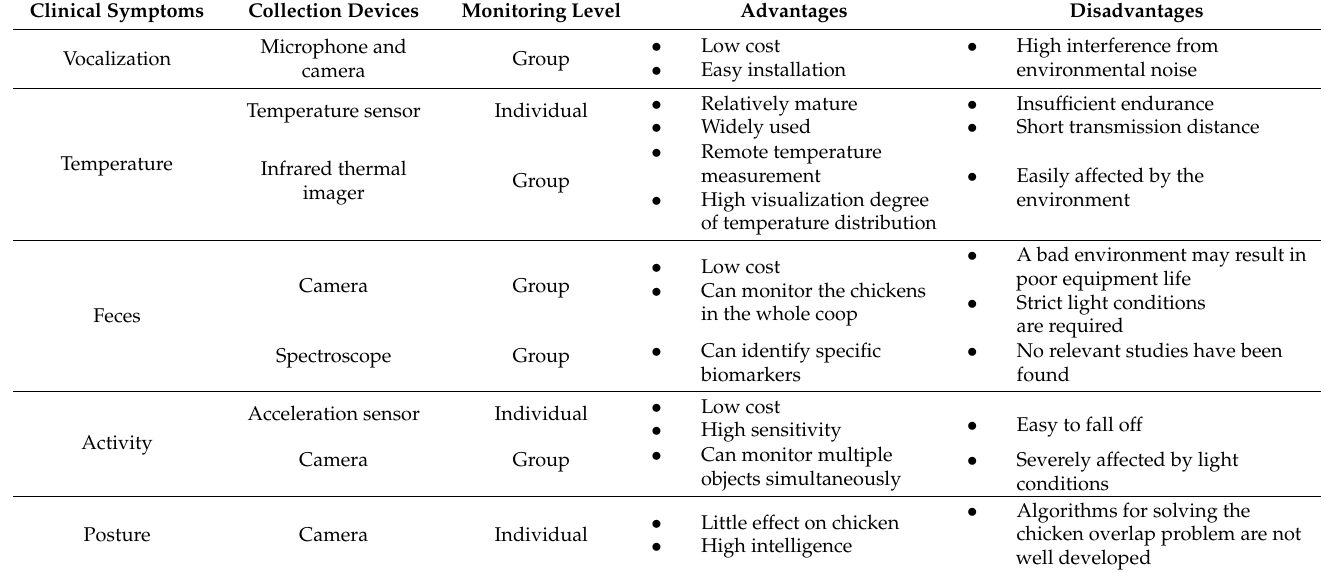
Table 2. Comparison of five clinical symptoms used for the early warning of